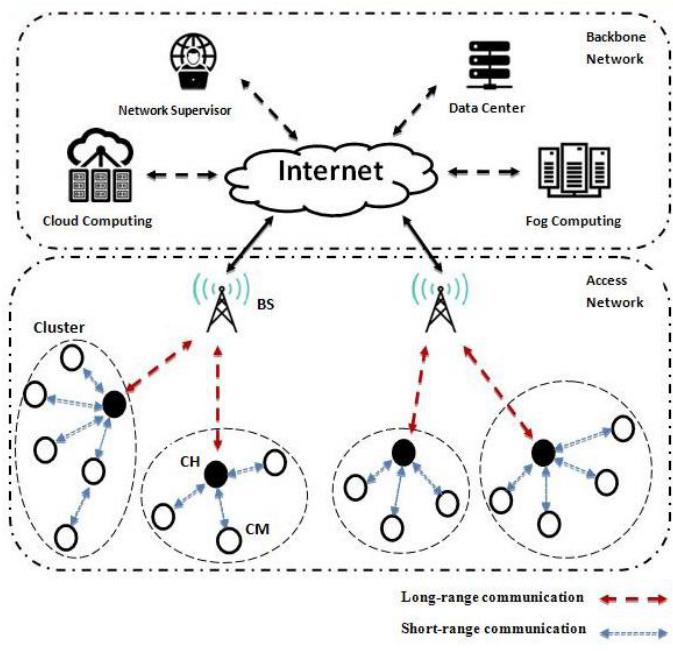
Figure 2. IoT network